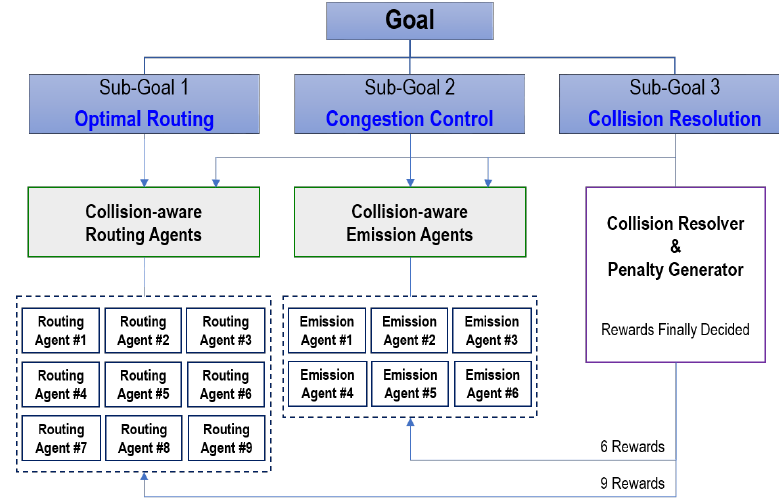
Figure 2. The goal-oriented strategy for cooperative reinforcement learning (RL) multiple